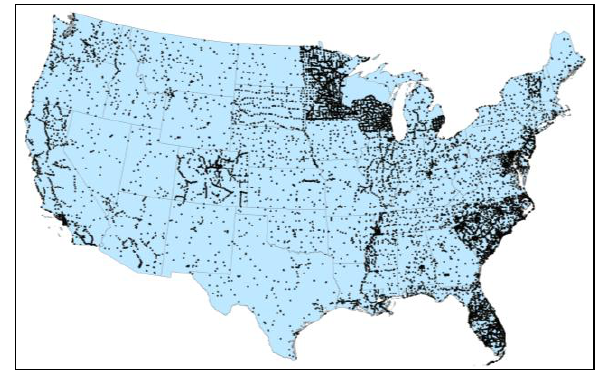
Figure 1. GPS benchmarks (18,207 points) used as GDEM v2 validation reference data.